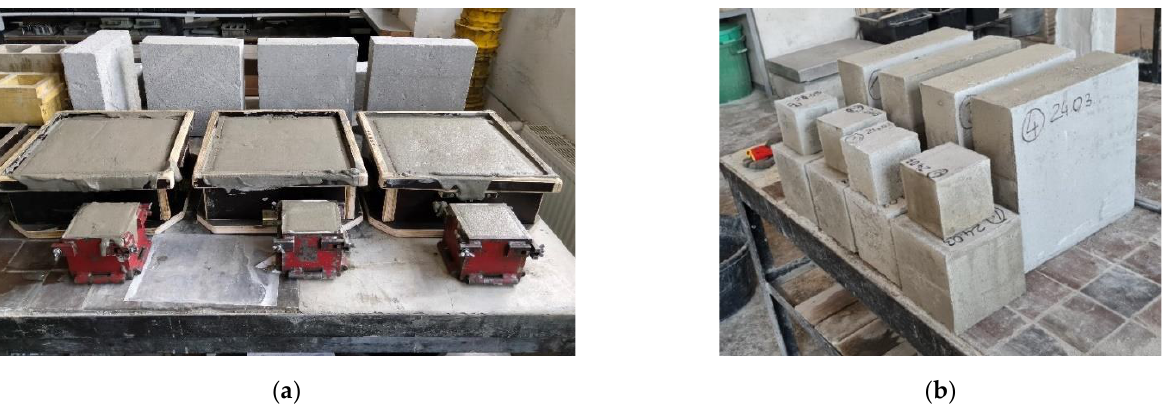
Figure 5. Exemplary foam concrete samples: ( a ) after filling the molds; ( b ) before cutting and